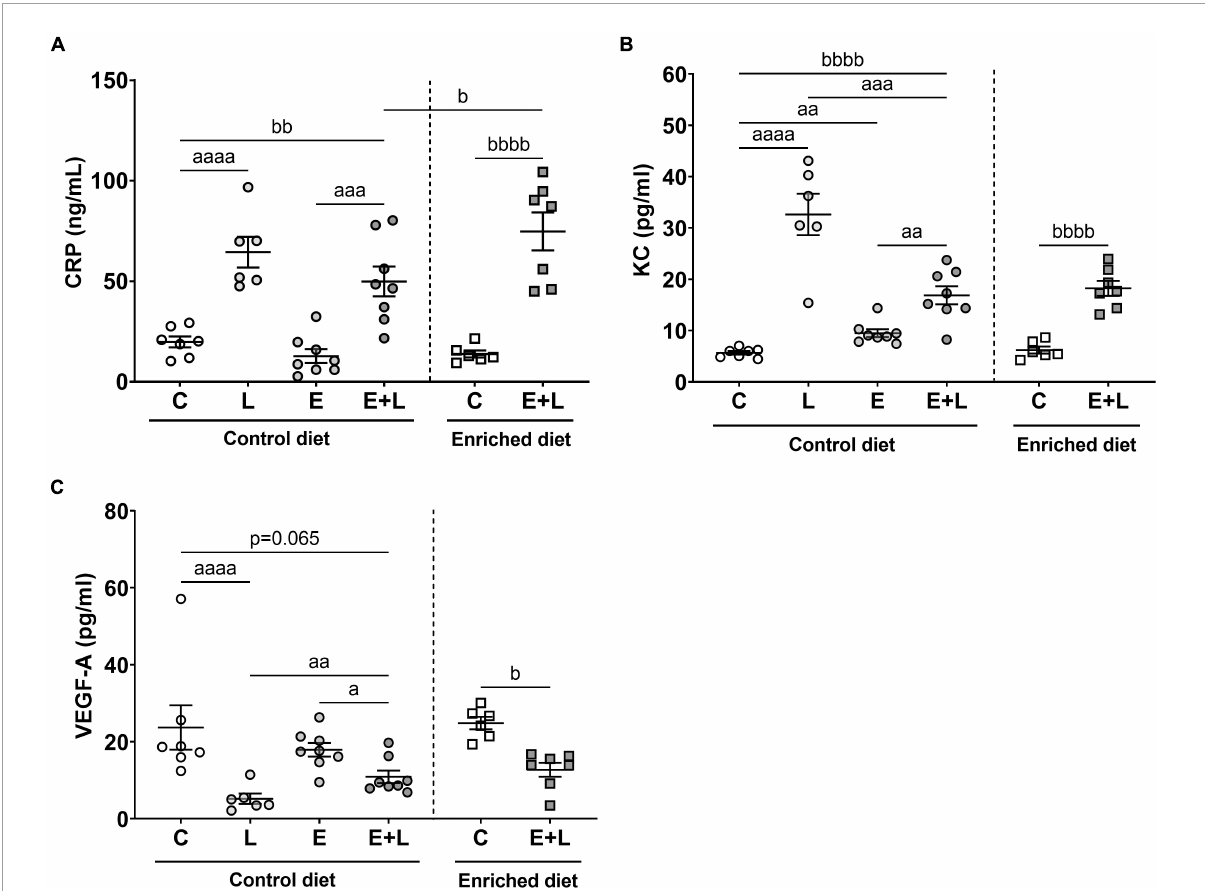
FIGURE4 Levels of inflammatory markers in BALF at the end of the experiment, 10 days after the last LPS exposure. The levels of CRP (A) , KC (B) , and VEGF-A (C) are presented. Data are presented as mean ± SEM. a p < 0.05; aa p < 0.01; aaa p < 0.001; aaaa p < 0.0001 (first analysis for elastase and/or LPS effects). b p < 0.05; bb p < 0.01; bbbb p < 0.0001 (second analysis for diet and/or E + L effects). C = control (control diet: n = 7; enriched diet: n = 6); L = LPS ( n = 6); E = elastase ( n = 8); E + L = elastase plus LPS (control diet: n = 8; enriched diet: n =